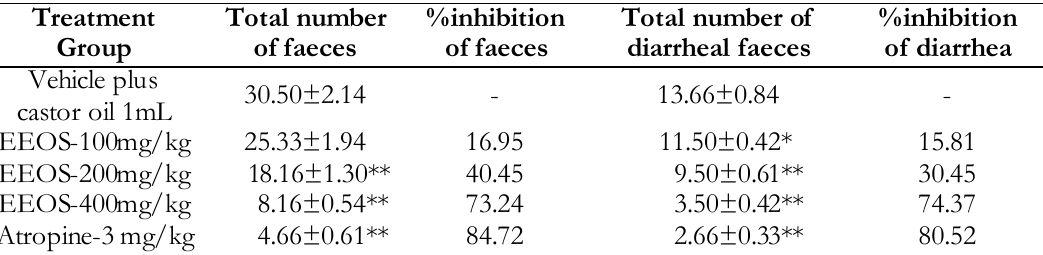
Table IV. Effect of EEOS on castor oil induced diarrheal